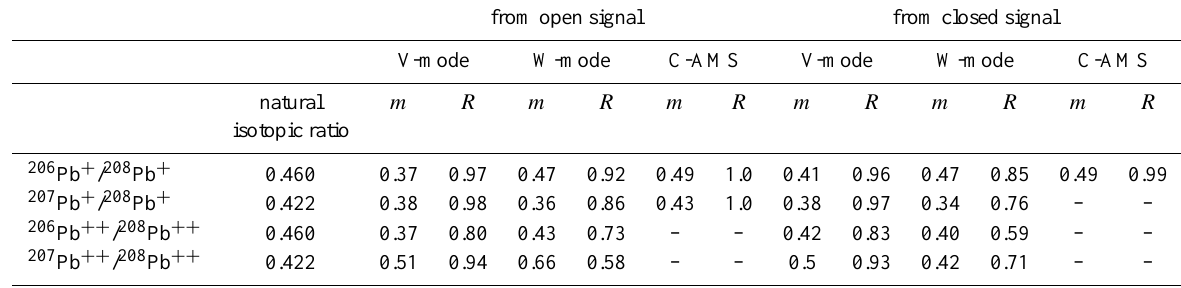
Table 1. Expected (deLaeter et al., 2003) and calculated lead isotopic ratios from linear fits (see Figs. 3 and 5); slope ( m ) and Pearsons R are shown.